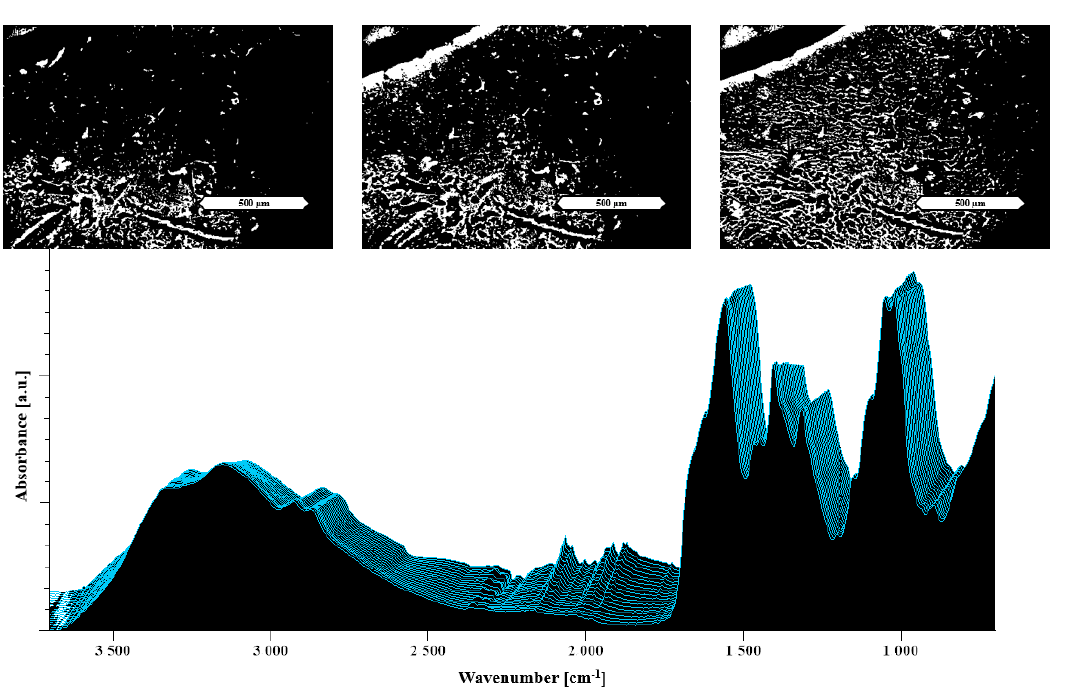
Figure 4. Hot stage microscopy (HSM) images at the top and temperature-resolved FTIR of 33% arginine in NaCMC at the bottom. The images show HSM images taken at RT, 90 °C arginine in NaCMC at the bottom. The images show HSM images taken at RT, 90 ◦ C and 130 ◦ C (from and 130 °C (from left to right). The displayed scale bar refers to 500 μ m. Each spectrum was left to right). The displayed scale bar refers to 500 µ m. Each spectrum was measured at measured at temperatures from 30 °C (measured first in the front) to 130 °C (in the back) by increasing steps of 5 °C.